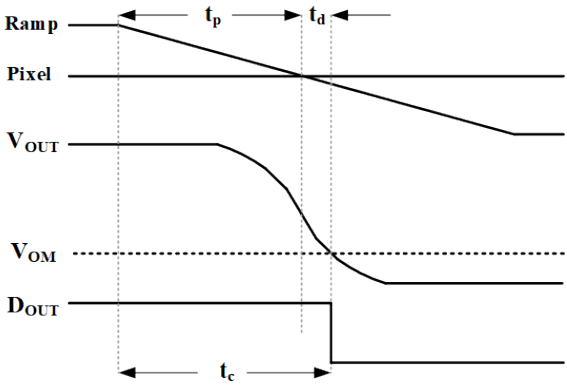
Figure 19. Timing diagram of the comparator comparison process.